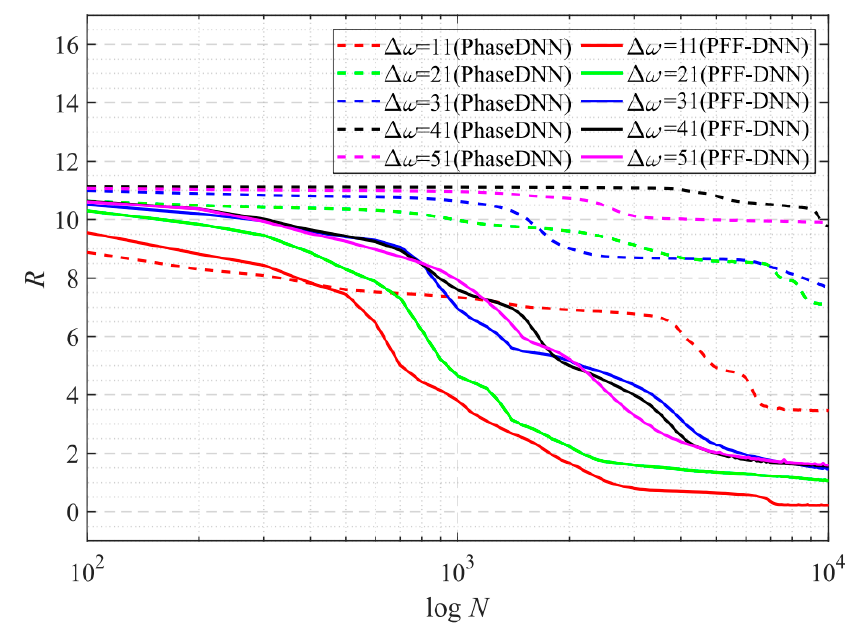
Figure 19. The influence of Δ ω on the convergence process.